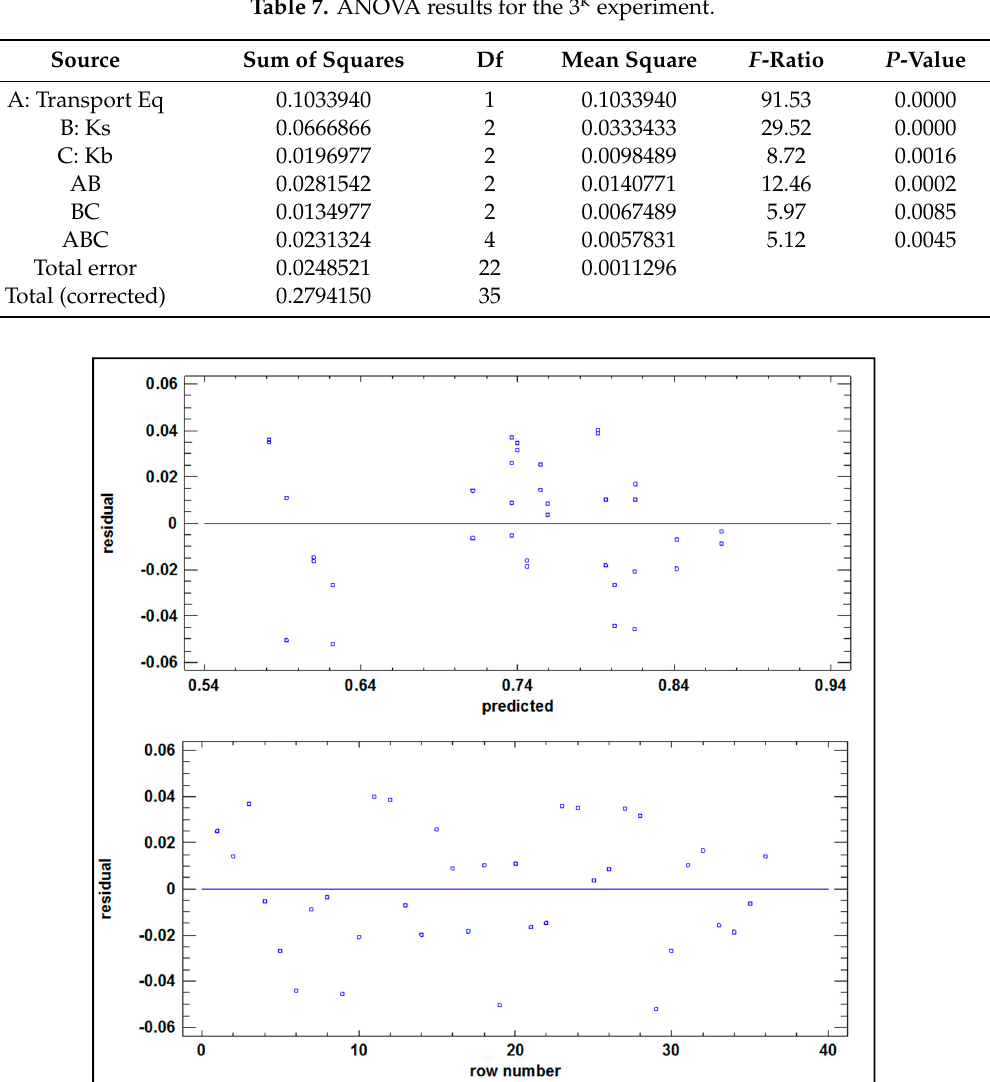
Figure 6 . Graphic verification of Homoscedasticity and Independence—Experiment 3 k . Figure 6. Graphic verification of Homoscedasticity and Independence—Experiment 3 k